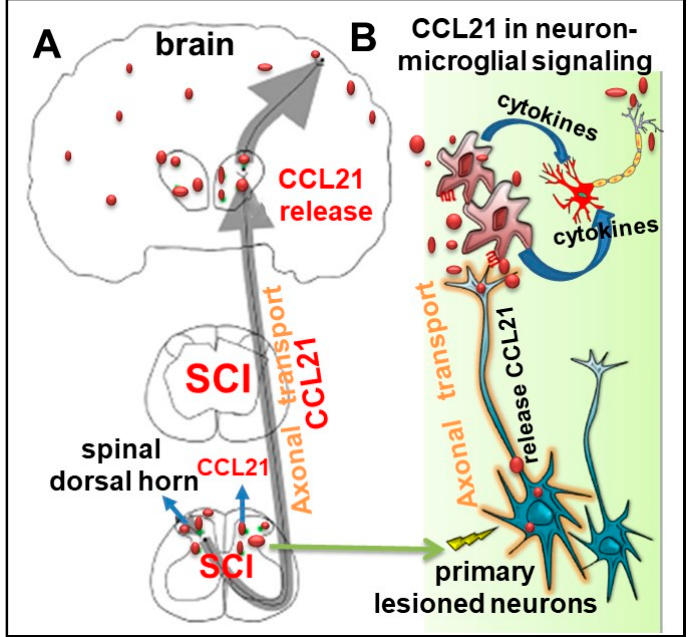
Figure 3. A schematic diagram for the cysteine-cysteine chemokine ligand 21 (CCL21) axonal transport and its role in neuron-microglia signaling following spinal cord injury (SCI). ( A ) CCL21 in damaged neurons is sorted into vesicles that are transported via axons and reach presynaptic structures and secreted into parenchyma. ( B ) Distal release of CCL21 triggers microglial activation at distant site from the lesion, which release proinflammatory cytokines and microparticles reinforcing neuronal damage. The latter causes more distant CCL21 release through their axonal transport.